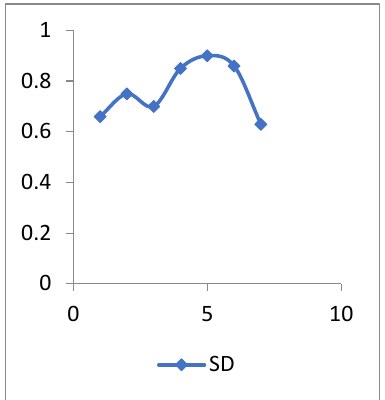
Figure 12. Accuracy, precision, and sensitivity comparison of different algorithms on diabetes disease preprocessed data.